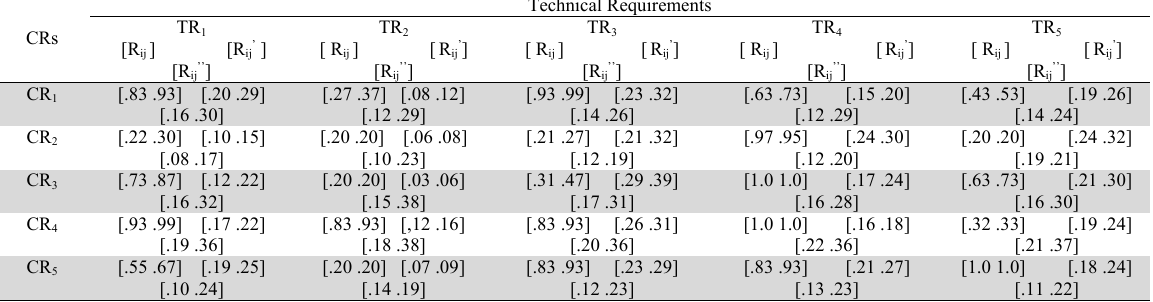
Technical Requirements